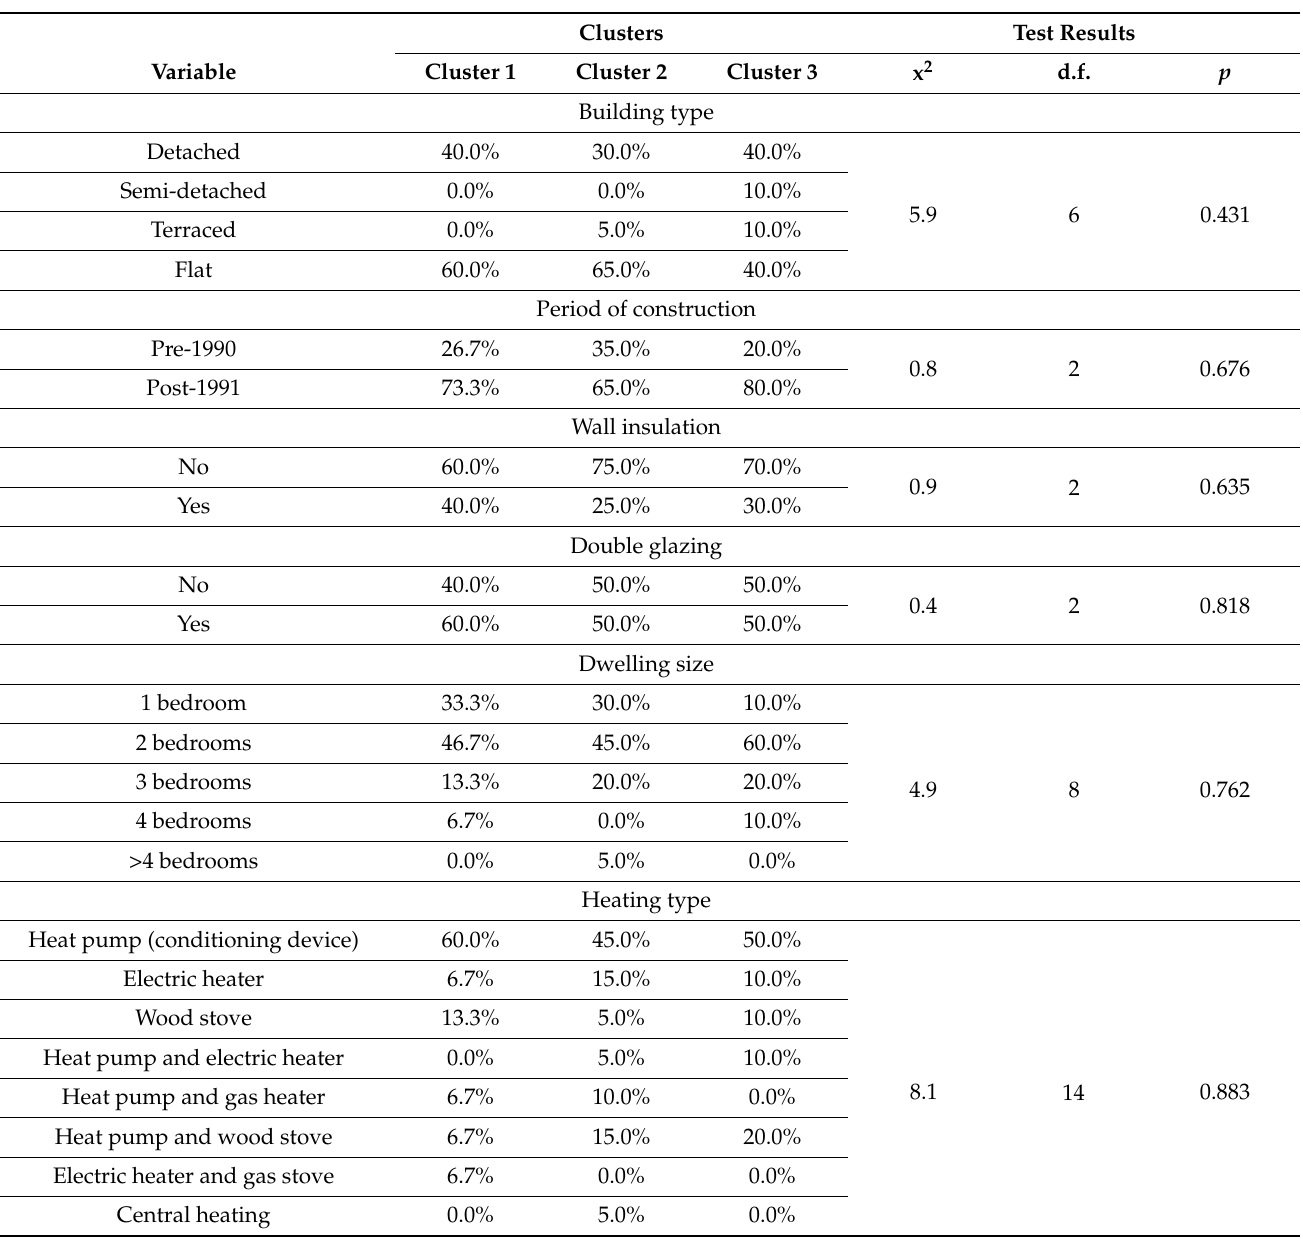
Table 11. Chi-squared analysis of building variables between clusters in winter.